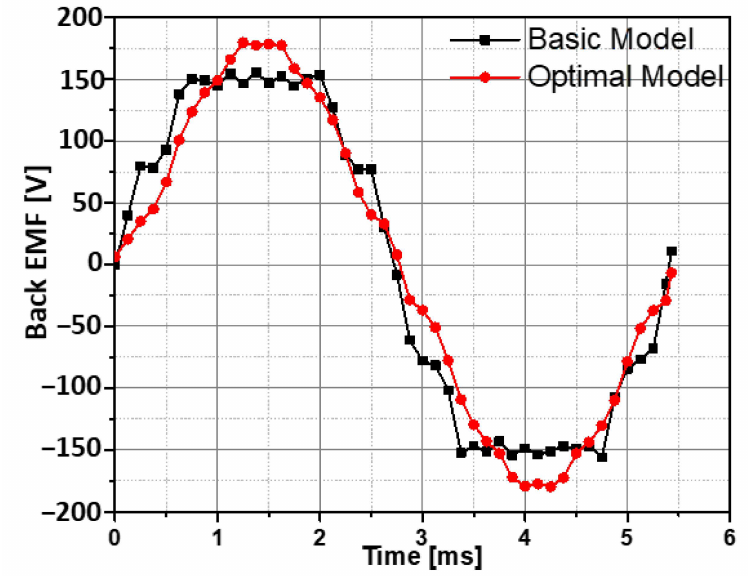
Figure 11. No- load back EMF